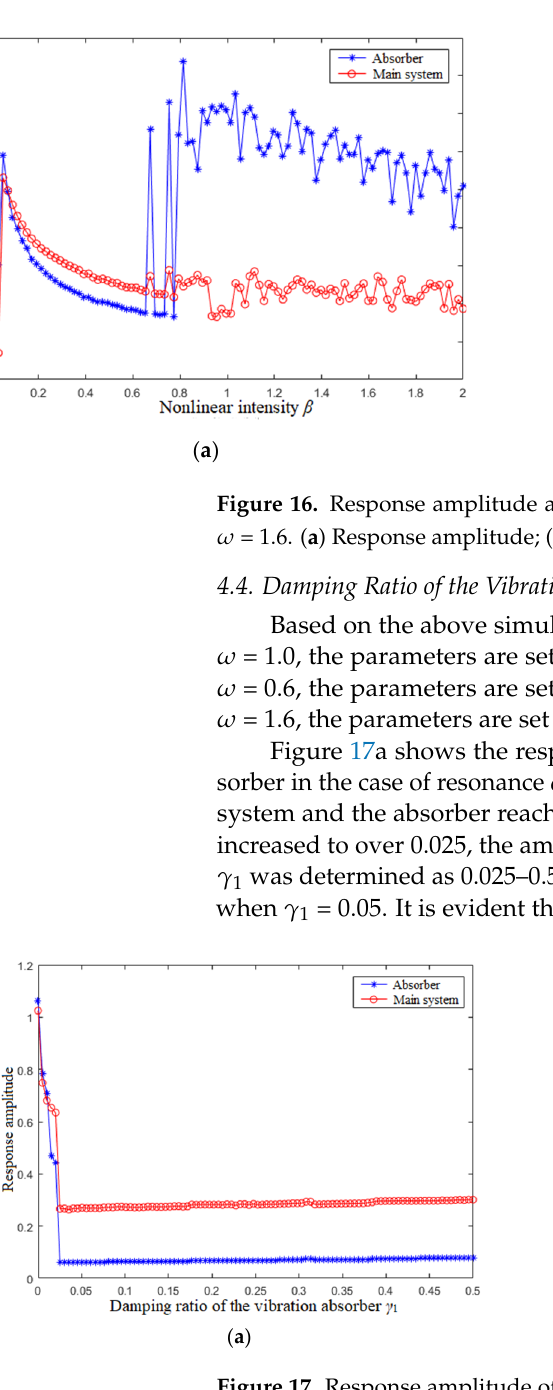
Figure 17. Response amplitude of two vibrators and phase diagram of main system in the case of resonance ω = 1.0. ( a ) Response amplitude; ( b ) Phase diagram ( γ 1 =